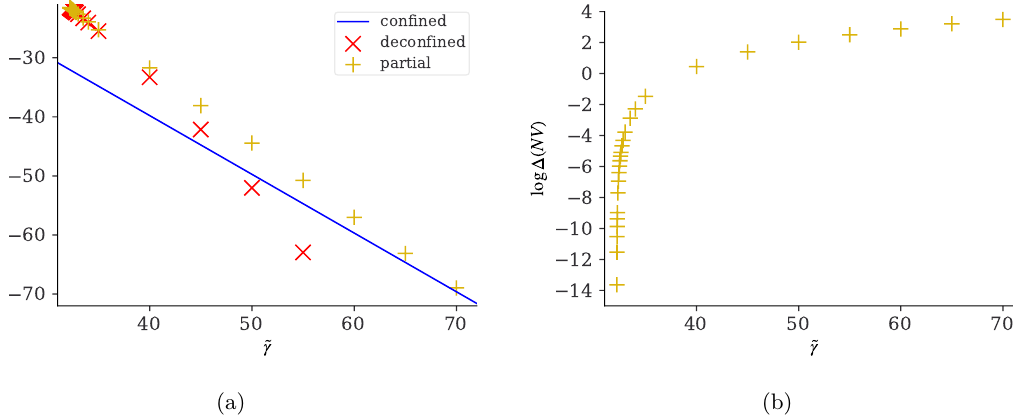
Figure 10. (a) θ = π numerical results for N times the free energy V as a function of ˜ γ for N = 30 , showing the confined phase (blue line), deconfined phase (red crosses), and partial phase (gold plus signs). We find a first-order transition, similar to the θ = 0 case in figure 6. (b) Our θ = π numerical results for log(∆ NV ) versus ˜ γ for N = 30 , with ∆ NV defined as in figure 6. Clearly the partial phase has higher free energy than the deconfined phase near the transition between them (which at N = ∞ is the GWW